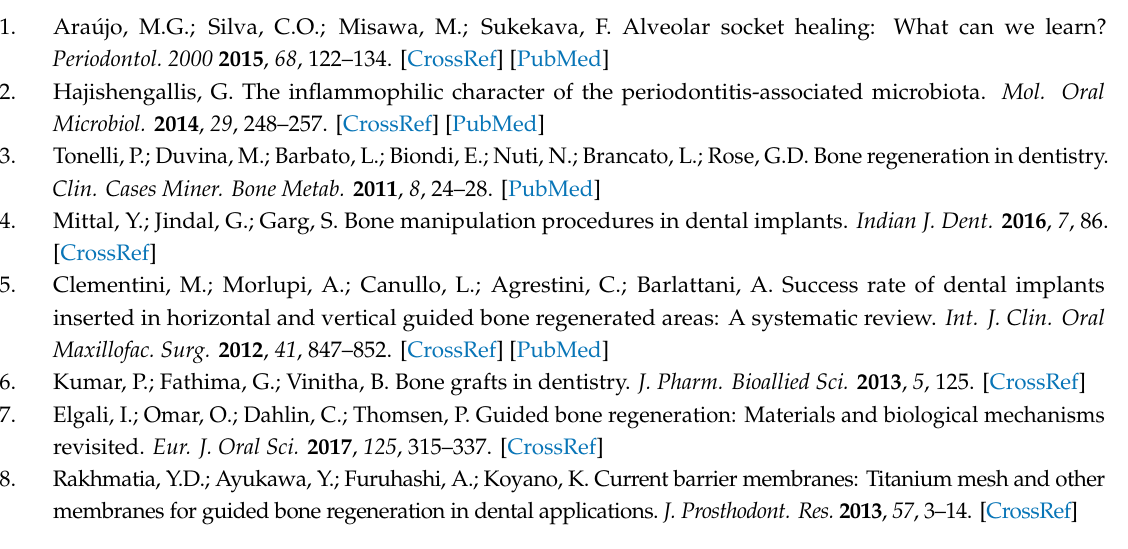
Figure S1. Observation of bone regeneration of the maxillary bone 120 days after implantation of a PCL membrane functionalized with BMP-2 (A, B, C, E) and non-functionalized PCL membrane (A, B, D, F). A 3D reconstruction (A) of frontal (B) and sagittal (C, D) sections of X-ray microtomography and Gomori trichrome staining (E,